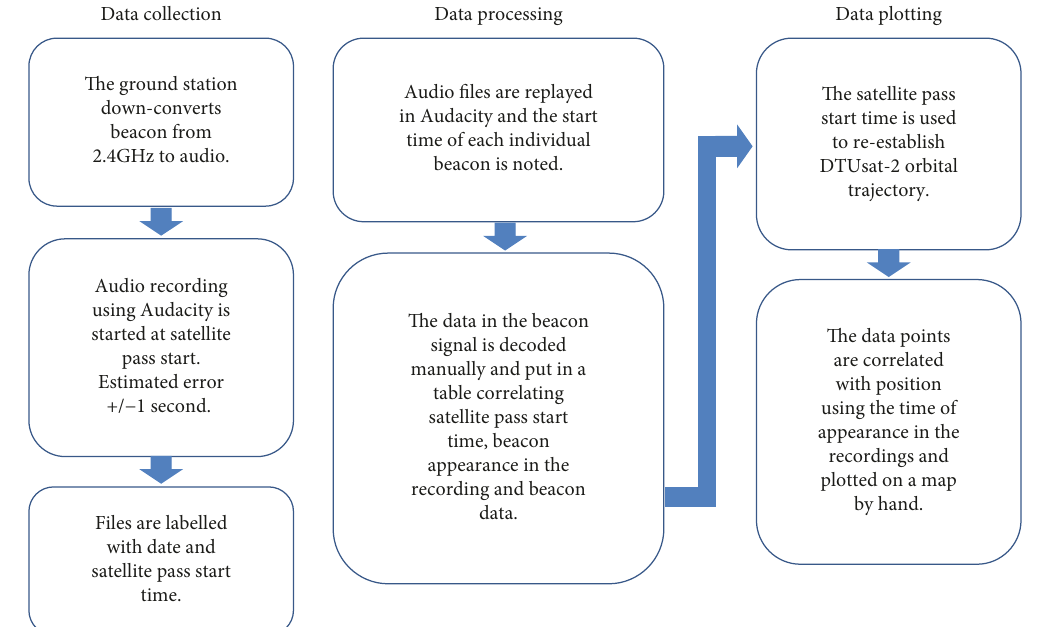
Figure 7: The fi gure shows a schematic representation of the data collection, processing, and plotting method. The actual data collected consists of audio fi les recorded during the satellite pass. The fi les are labelled with the pass start time (AOS). Beacon information is extracted at a later point in time by decoding the Morse beacons manually. The correlated data, position and beacon count number, is then plotted on a map.